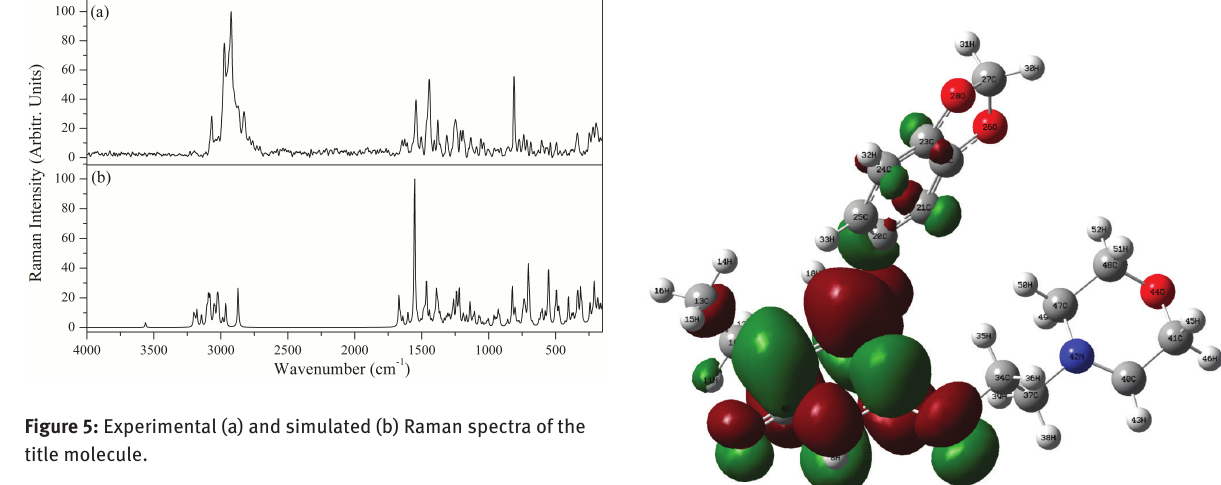
Figure 7: HOMO plot of the title compound.